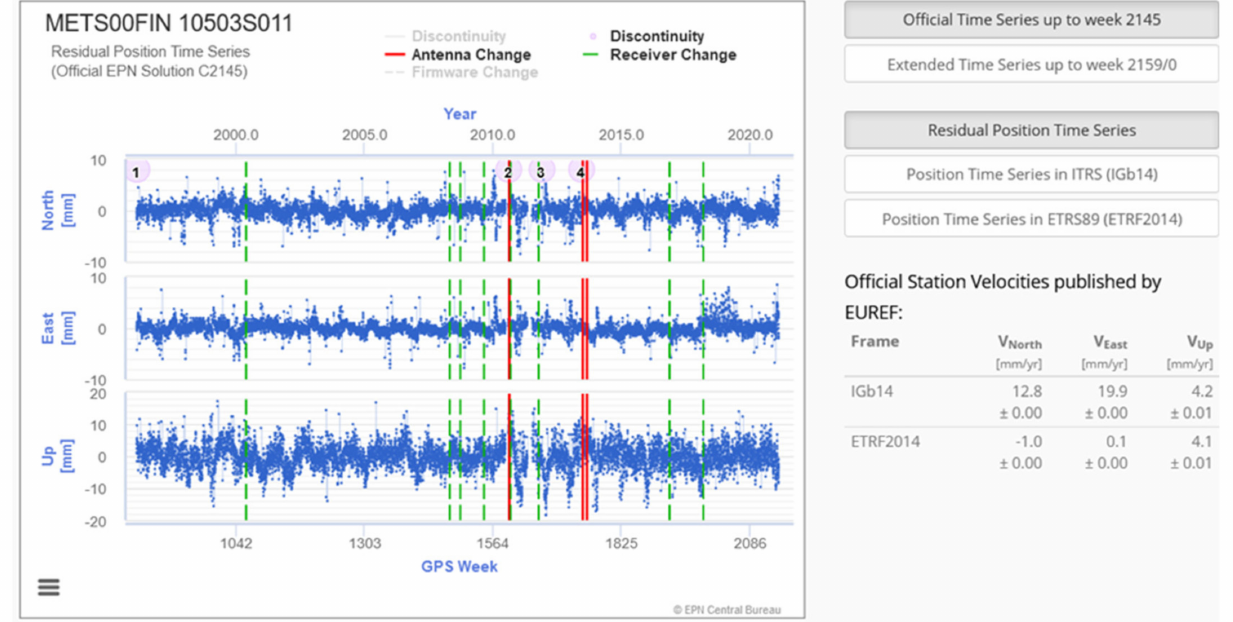
Figure 14. Residual position time series of GNSS station Metsähovi in Finland [Source: EPN website at https://www.epncb.oma.be/_productsservices/timeseries/ (accessed on 17 May